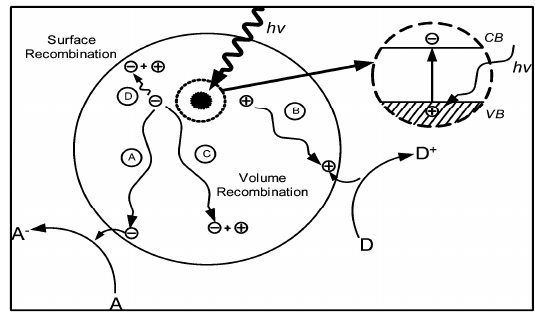
Figure 1. Schematic diagram of photo-excitation and electron transfer process (adapted from [63]).